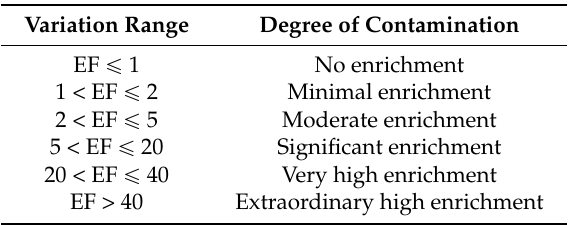
Table 1. Classification of enrichment factors